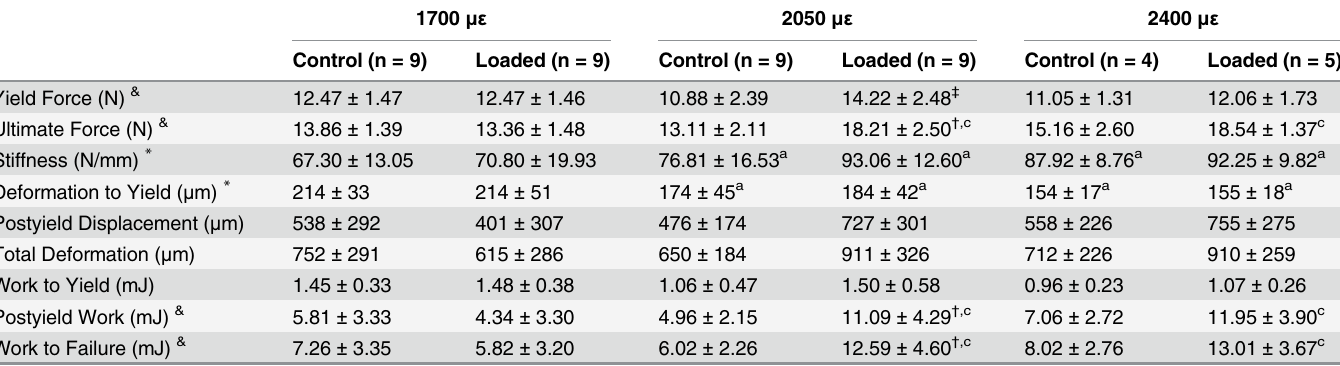
Table 3. Structural Mechanical Properties From 4-Point Bending of the Mid-Diaphysis.